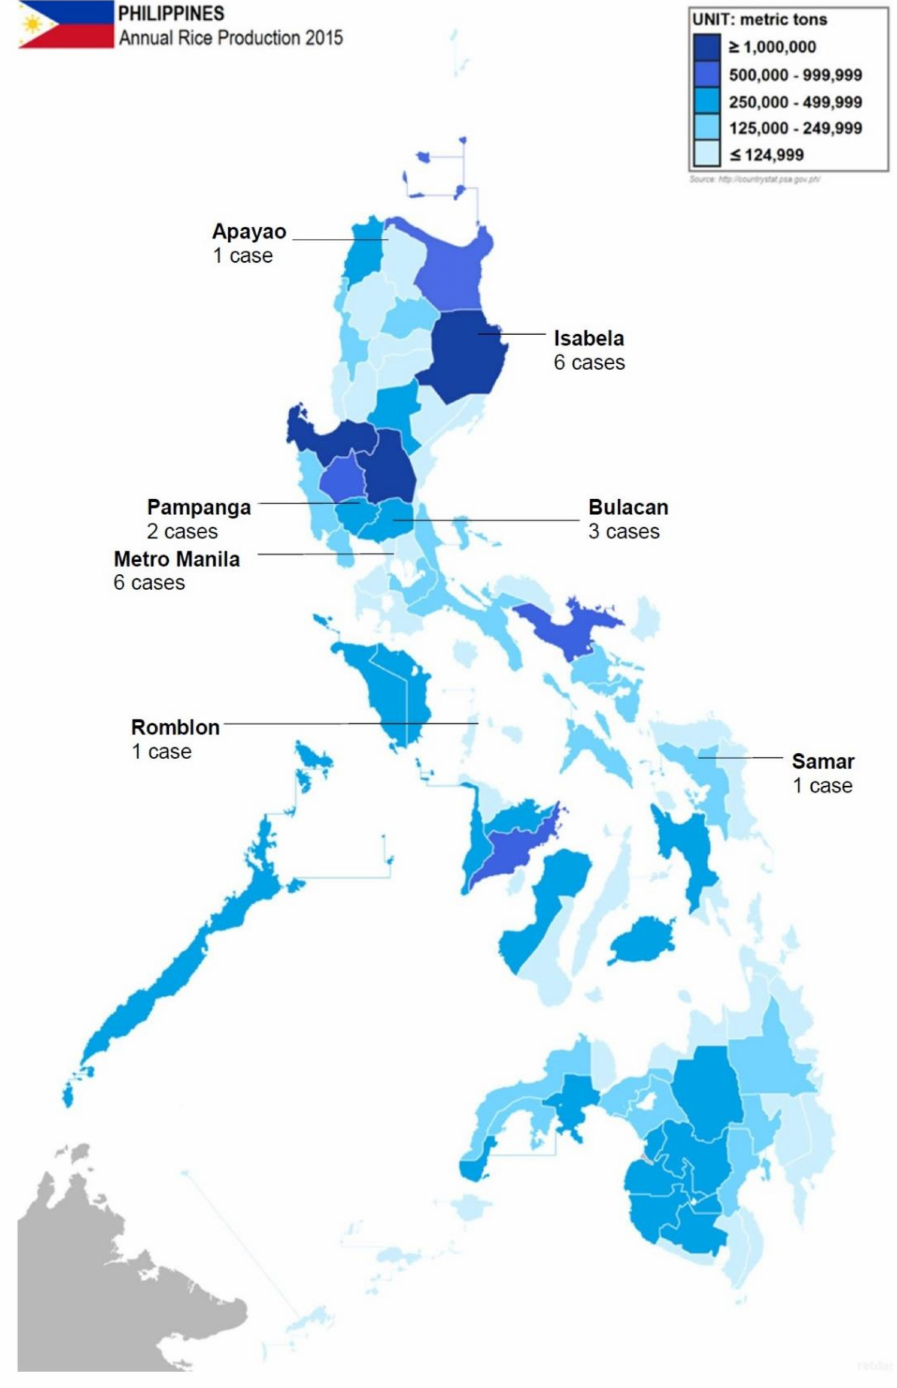
Figure 1. Distribution of indigenous cases of melioidosis in the Philippines (reported from 2002 to 2016) and the amount of rice production per province. Original image imported from: https://commons. wikimedia.org/wiki/File:Philippine_provinces_Annual_Rice_Production_2015.png. The most common co-morbidity was diabetes mellitus, comprising 58.5% of cases, followed by cardiovascular disease (which includes hypertension and coronary artery disease) at 26.82%. Diabetes mellitus is the most common co-morbidity and risk factor found in the literature